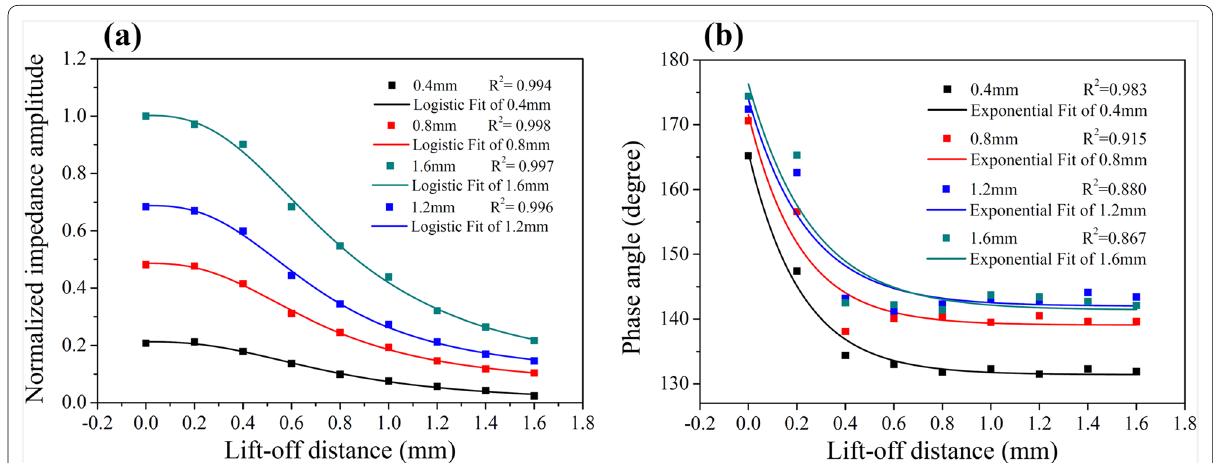
Figure 10 Relationship between the lift-off distance and ( a ) the normalized impedance amplitude and ( b ) the impedance phase angle of the captured defect EC signals